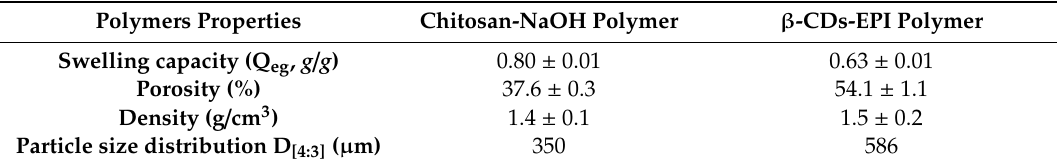
Table 1. The swelling capacity, porosity and particle size distribution of both adsorbents. Polymers Properties